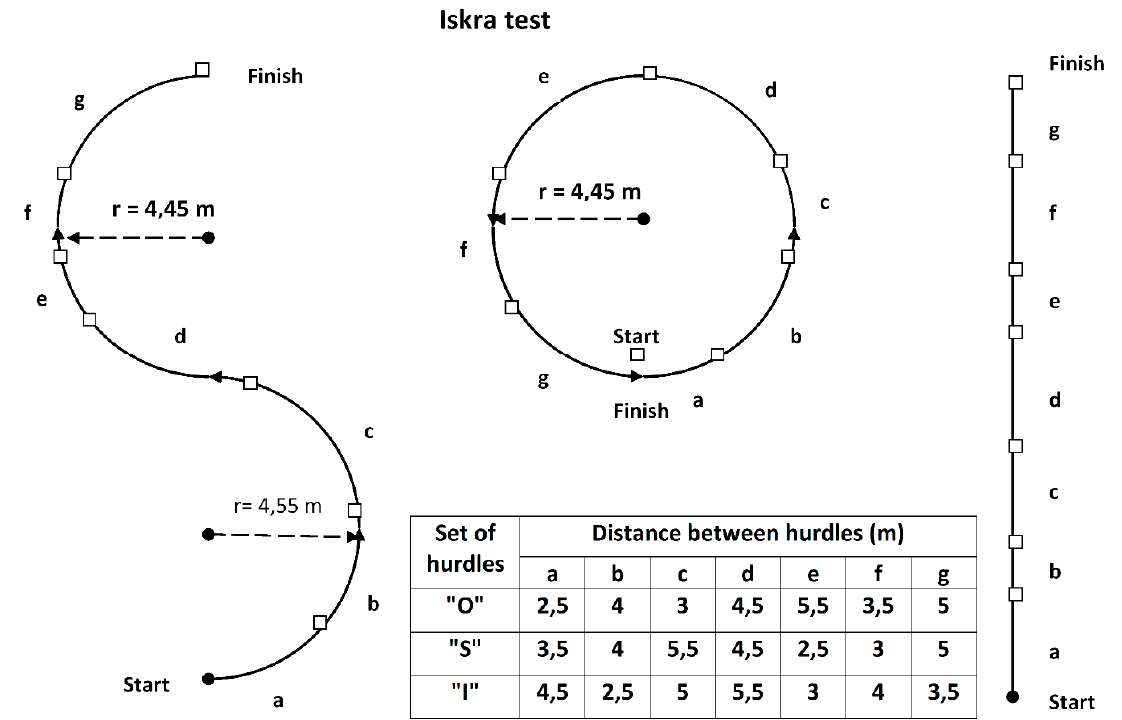
Figure 1. Hurdle arrangement (a square denotes a hurdle) and the intervals between hurdles for tests performed in a circle, on a curve, and on a straight track.